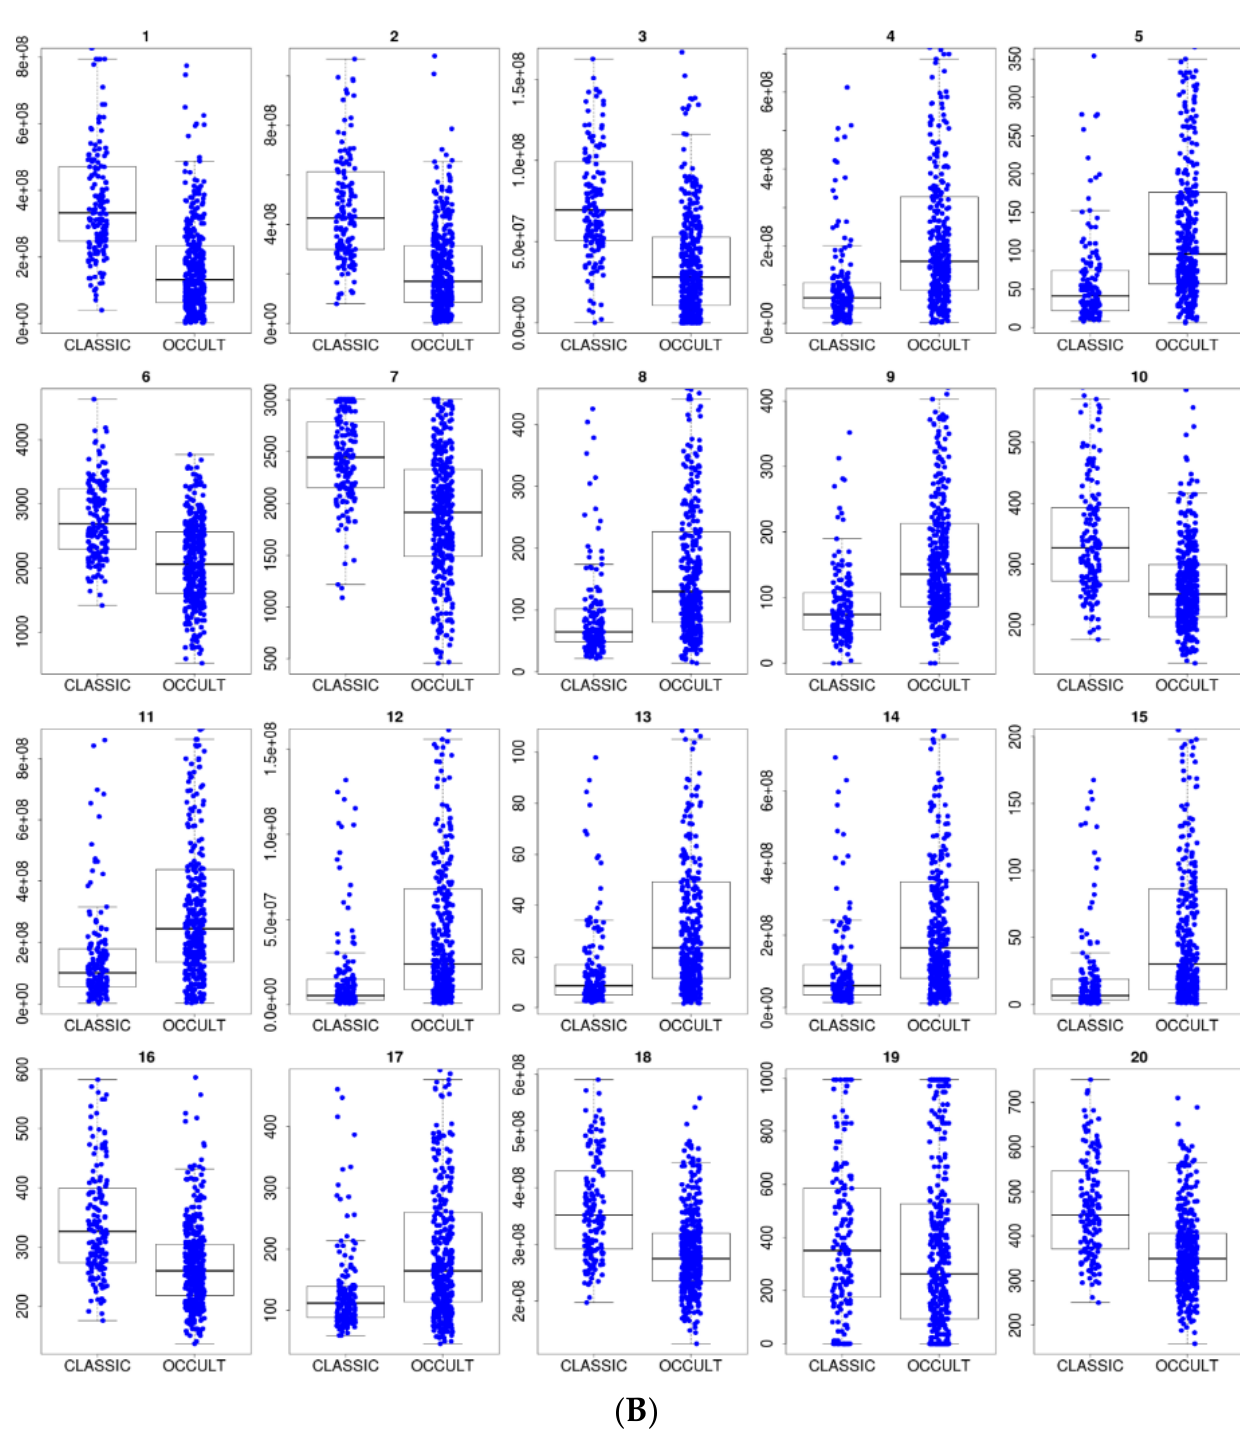
Figure 4. ( A ) Recursive feature elimination cross-validation. Optimal performance for predomi- nantly classic versus occult was reached with 101 features out of 106, and only 21 features were necessary to sustain the average model performance of 91% AUROC. ( B ) Distribution of the top 20 feature values in the training data (predominantly classic vs. occult